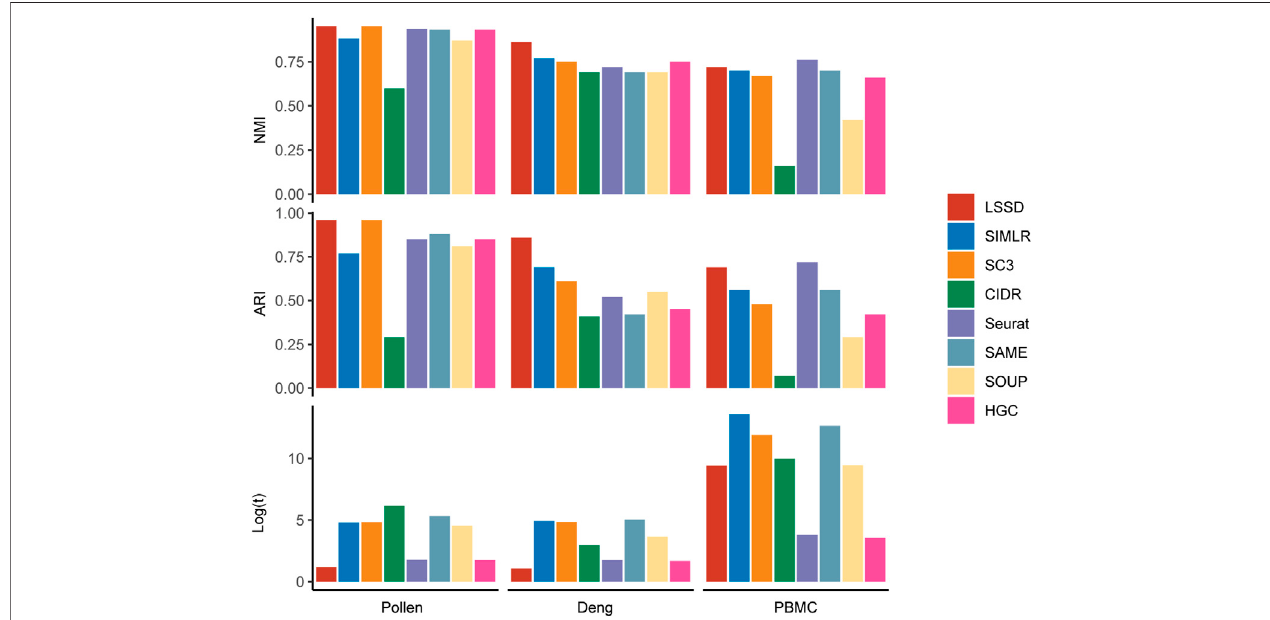
FIGURE 5 | Comparison of clustering performance using LSSD, SIMLR, SC3, CIDR, Seurat, SAME, SOUP, and HGC. The benchmark results on the three real scRNA-seq datasets are evaluated by NMI and ARI, where the larger values indicate more concordance between the clustering labels and the true labels. Less running time means higher computational ef fi ciency. Our LSSD approach shows appealing clustering performance compared with the other seven methods.